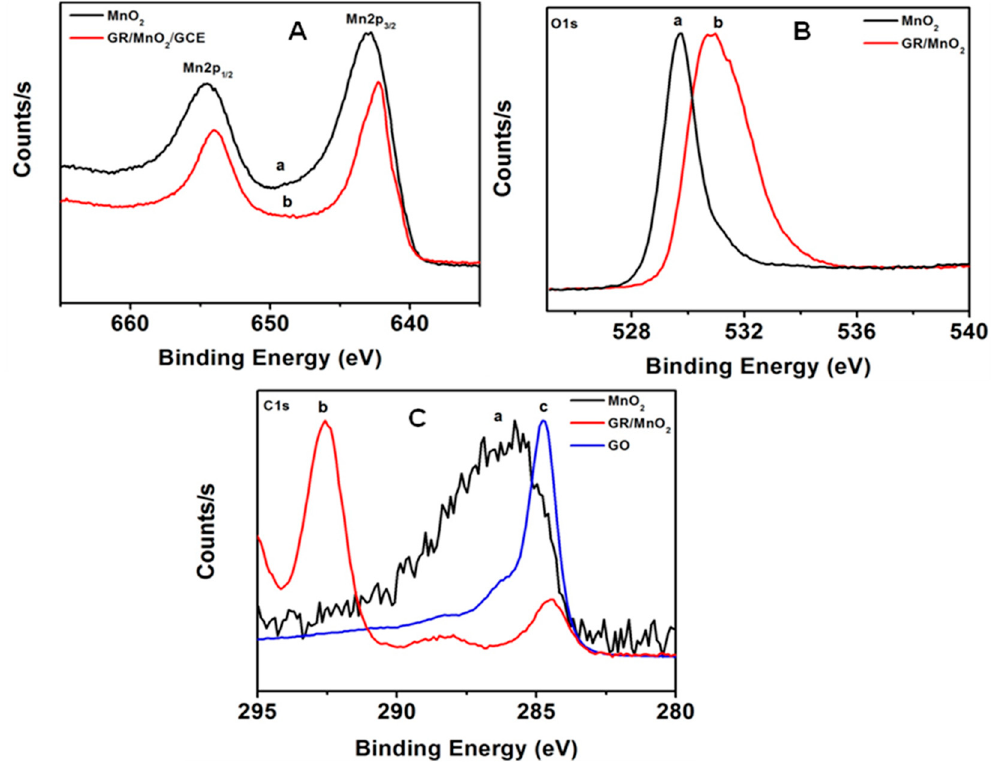
Figure 4. High-resolution XPS spectra of MnO 2 -GR composite ( A ) Mn 2p; ( B ) O 1s and ( C ) C